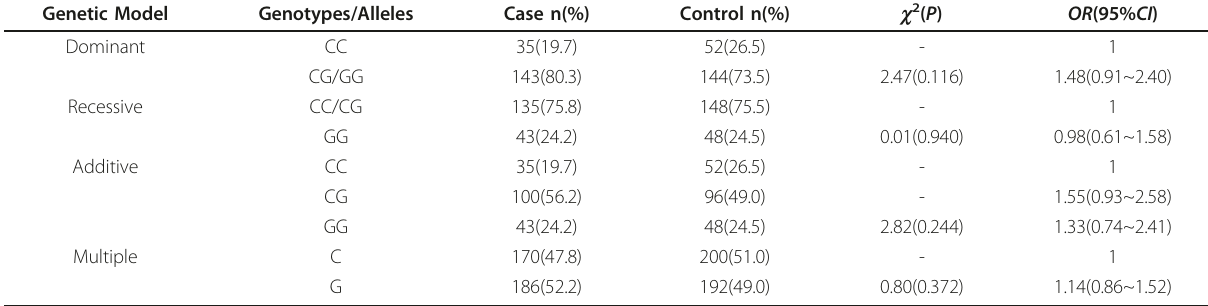
Table 4 Frequency of rs9904341 genotypes/alleles under different genetic models